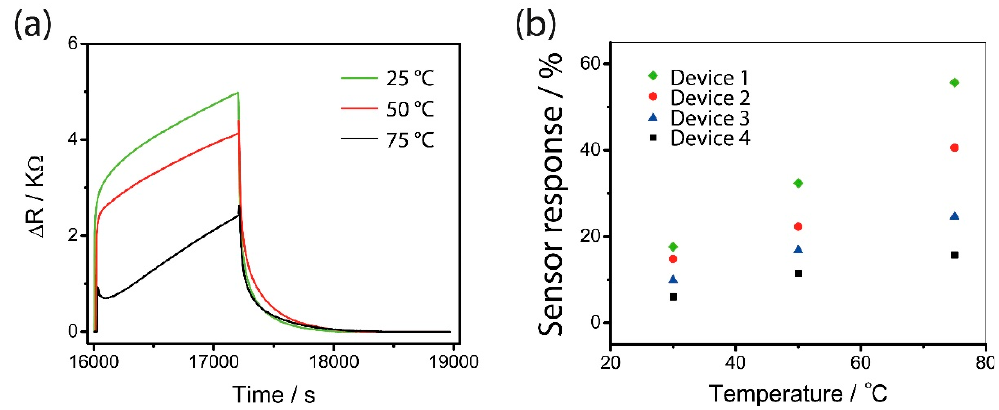
Figure 6. ( a ) Resistance response of Pd–rGO device to 3300 ppm hydrogen at different temperature; ( b ) Sensor response as a function of temperature for the data in ( a ) [89]. Copyright (2020), with permission from Elsevier.